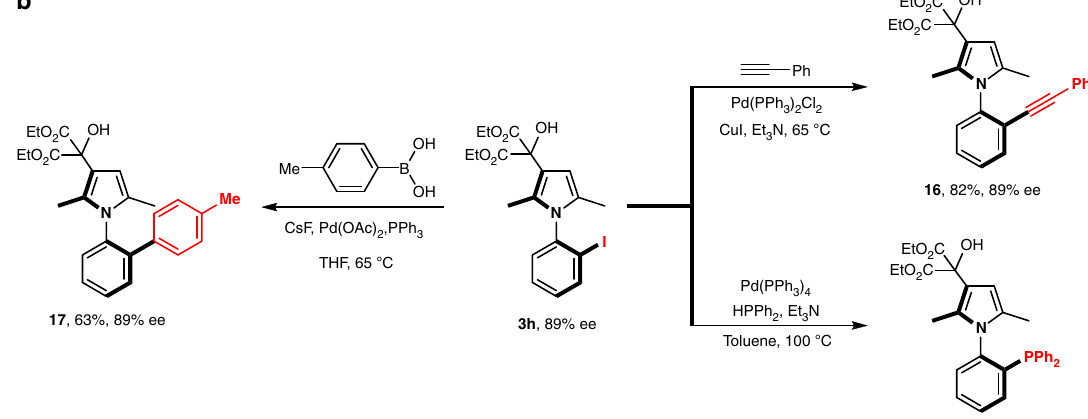
reduced pressure and puri fi ed by fl ash chromatography eluted with PE/EA (10/1 to 5/1) to afford the corresponding axially chiral arylpyrrole products ( R )- 3 . For 3g – 3i , m , 3r , the reaction conditions are as follows: an oven-dried 10mL of Schlenk tube was charged with arylpyrroles 1 (0.30 mmol), ( S )- C8 (0.02 mmol) and 1.5 mL of mixed solvent (cyclohexane/methylcyclohexane = 1/1). After the